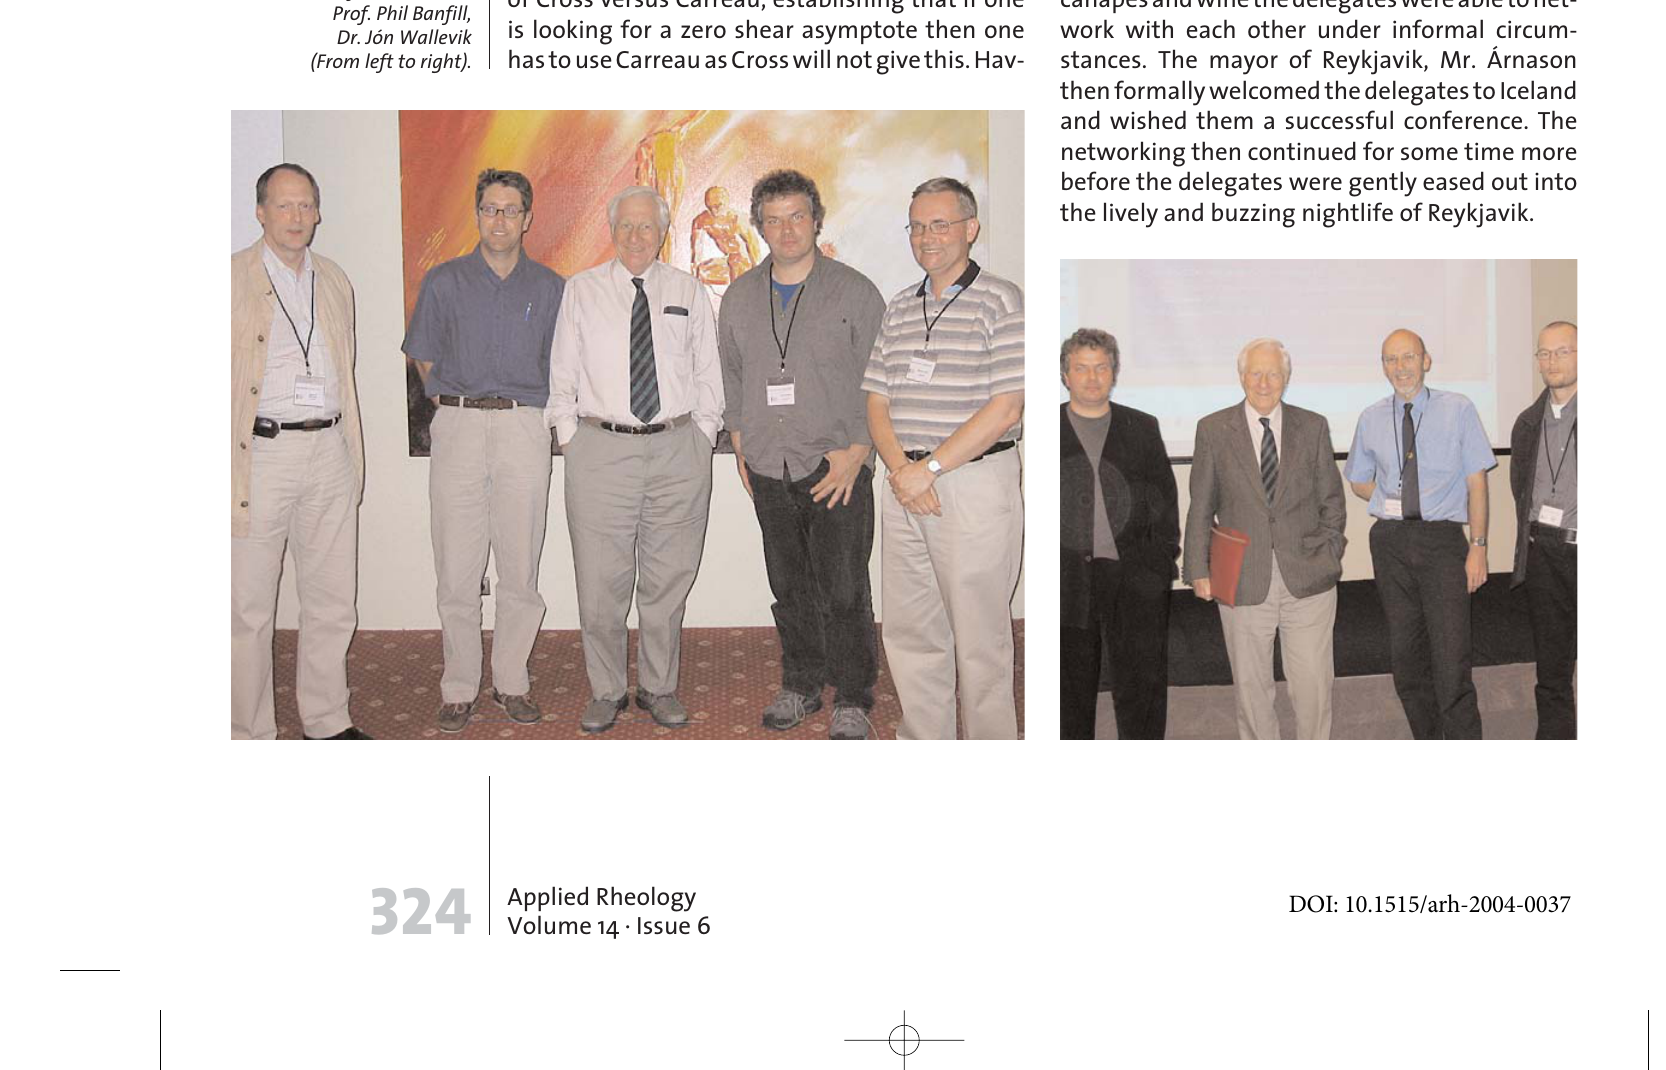
Figure 1 (left): The Course Speakers together with conference chairman. Dr. Olafur Wallevik (Conference chairman), Prof. Mats Stading, Prof. Ken Walters, Dr. Peter Fischer, Prof. Karsten Qvist (From left to right). Figure 2 (right): Invited Speakers: Dr. Peter Fischer, Prof. Ken Walters, Prof. Phil Banfill, Dr. Jón Wallevik (From left to